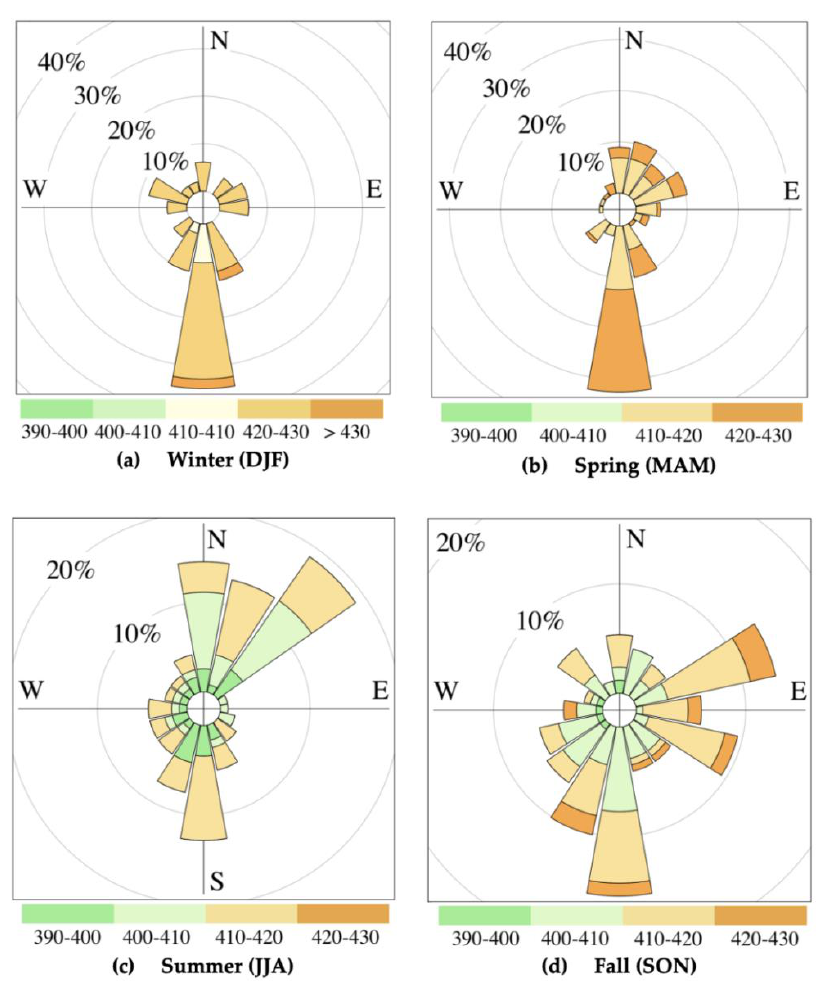
Figure 10. Angular distribution of atmospheric CO 2 concentrations throughout the period of observations (September 2018 – February 2020): frequency of counts (%) and dry mole fractions (ppm). Afternoon data records for CO 2 and corresponding wind directions (1 – 4 pm LT) are shown.